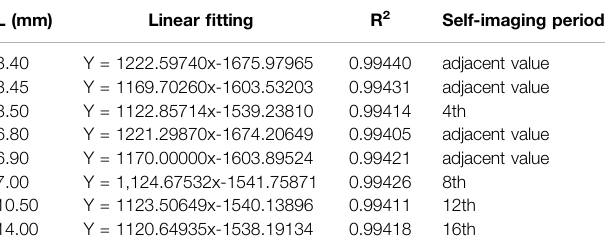
TABLE 1 | Linear fi tting of wavelength shift when D 1 (cid:2) 30 μ m.